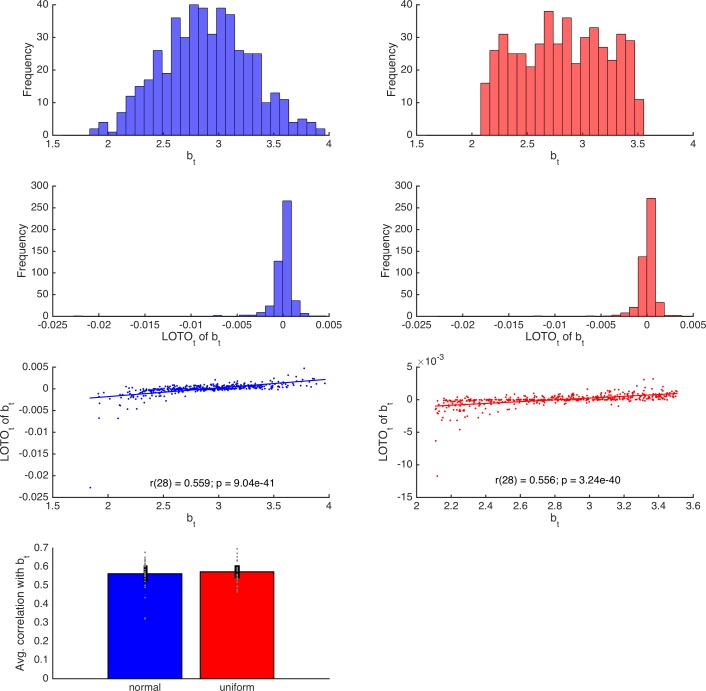
Comparison of LOTO distributions for parameter b of the HD-LBA model.The first and second rows depict the distributions of true parameters and LOTO estimates, respectively, fornormally (left, blue) and uniformly (right, red) distributed true parameters. The third row depicts correlations between true parameters and LOTO estimates for an example participant. The lowest panel depicts average correlations for all 30 participants for the normally and uniformly distributed true parameters.